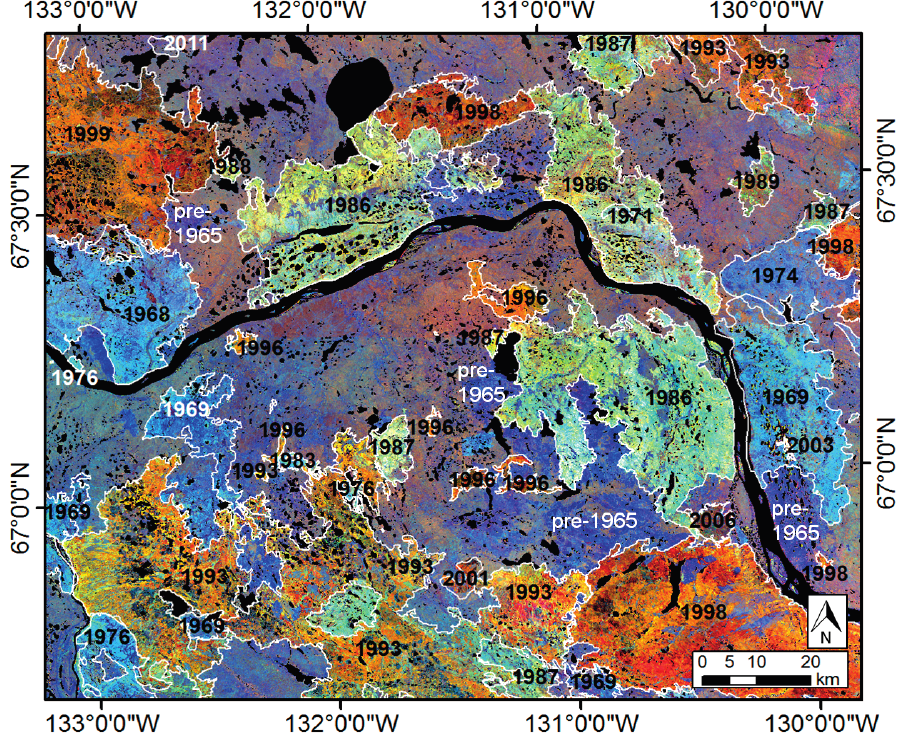
Figure 4. NWT fire history perimeters (1965–2011) overlaid on the TC trend image composite. Regenerating stands initiated by fires before 1965 appear dark